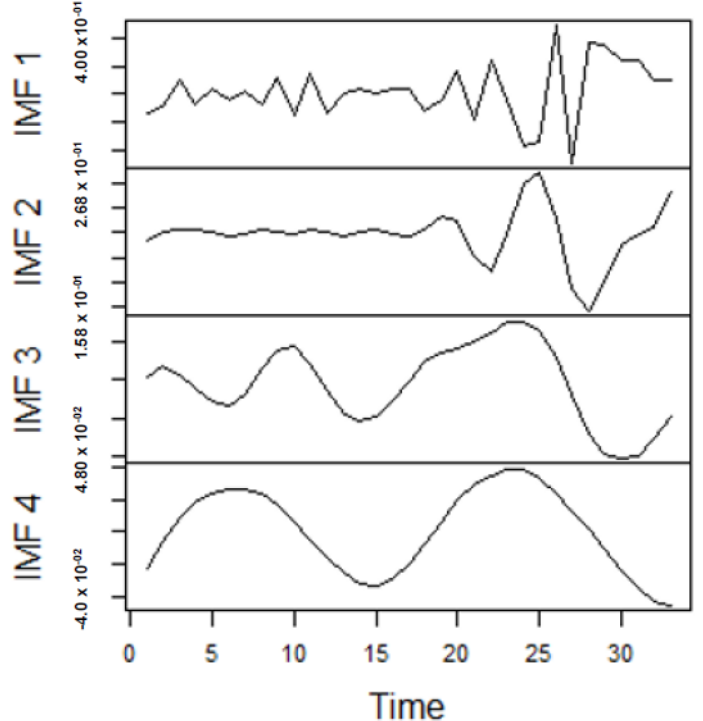
Figure 5. Part A: Parts of the IMFs for US gas prices.